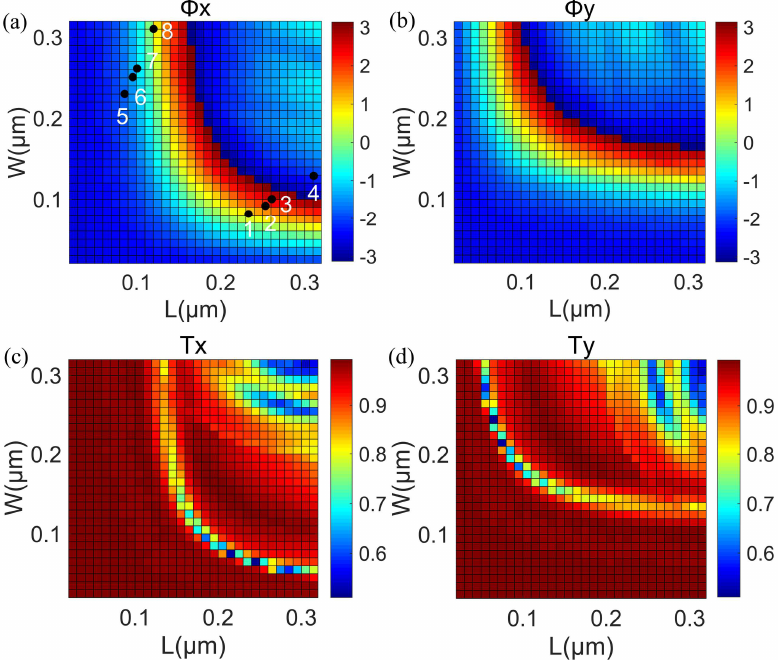
Figure 3. ( a , b ) For x − and y − polarized light incidences, phase shifts Φ x and Φ y are used as the function of the L and W of nanobricks, respectively. ( c , d ) The transmittance Tx and Ty are the function of the L and W of nanobricks for the incident x − and y − polarized light, respectively. The L and W of unit cells from 1 to 4 were L = 230, 250, 260, and 310 nm, and W = 85, 95, 100, and 130 nm. The unit cells from 5 to 8 were arranged by rotating the nanobricks from 1 to 4 at every angle of 90 ◦ clockwise.